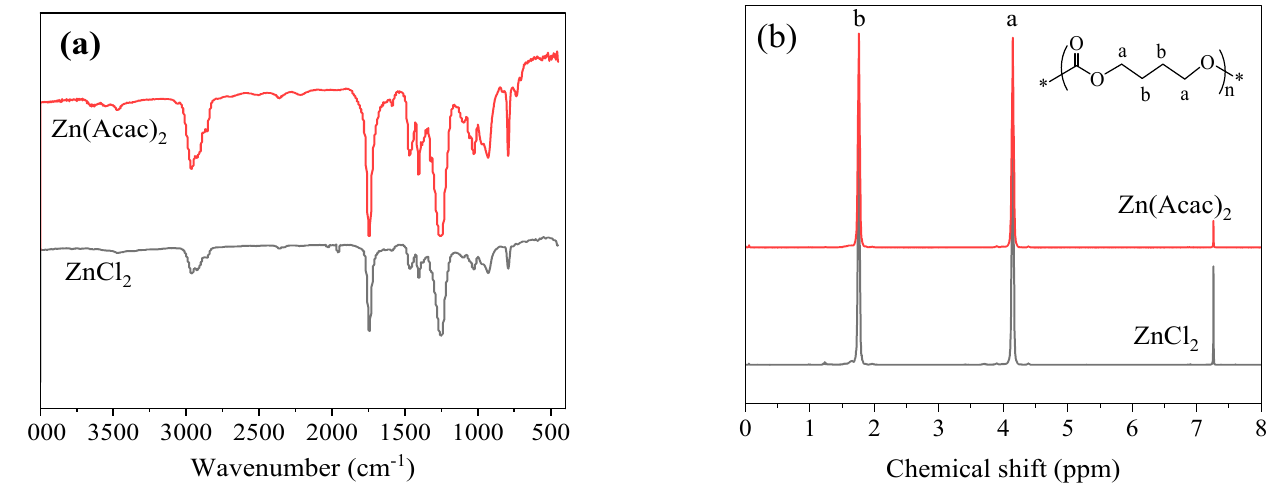
Figure 1. ( a ) FT-IR spectra and ( b ) 1 H-NMR spectra of resultant copolymers obtained over ZnCl 2 and Zn(Acac) 2 .